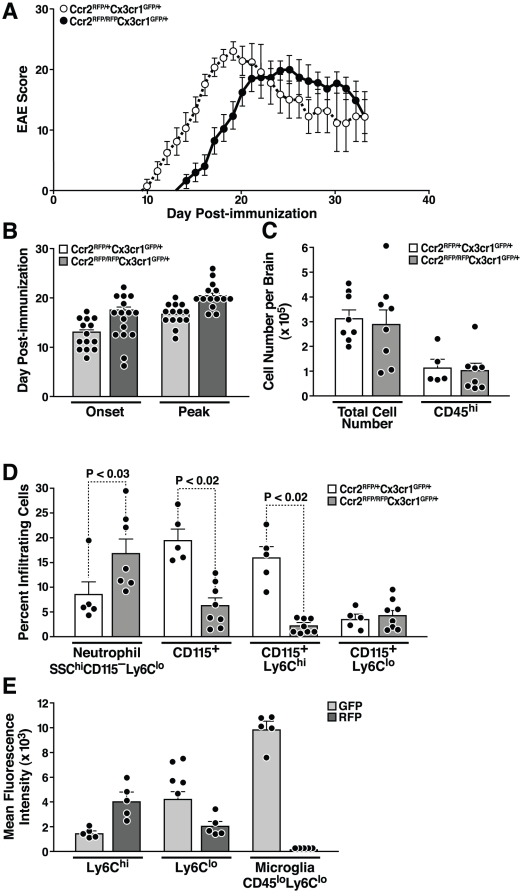
CCR2-deficient mice exhibit delayed onset EAE and decreased monocyte recruitment to the CNS.(A) Ccr2RFP/+Cx3cr1GFP/+ and Ccr2RFP/RFPCx3cr1GFP/+ mice were immunized with MOG peptide 33–55 and scored daily for neurological signs. (B) EAE symptom onset and peak disease. (C) Total number of brain mononuclear cells and CD45hi infiltrating cells at peak disease. (D) CD45hi infiltrating cells were analyzed to quantify total neutrophils (SSChi, CD115−, Ly6Clo), monocytes (CD115+), and monocyte subsets (CD115+/Ly6Chi/lo), (E) CX3CR1 GFP and CCR2-RFP fluorescence intensities in monocyte subsets and microglia. Data points represent individual mice. Values are mean ± SEM. Results are representative of two similar experiments.